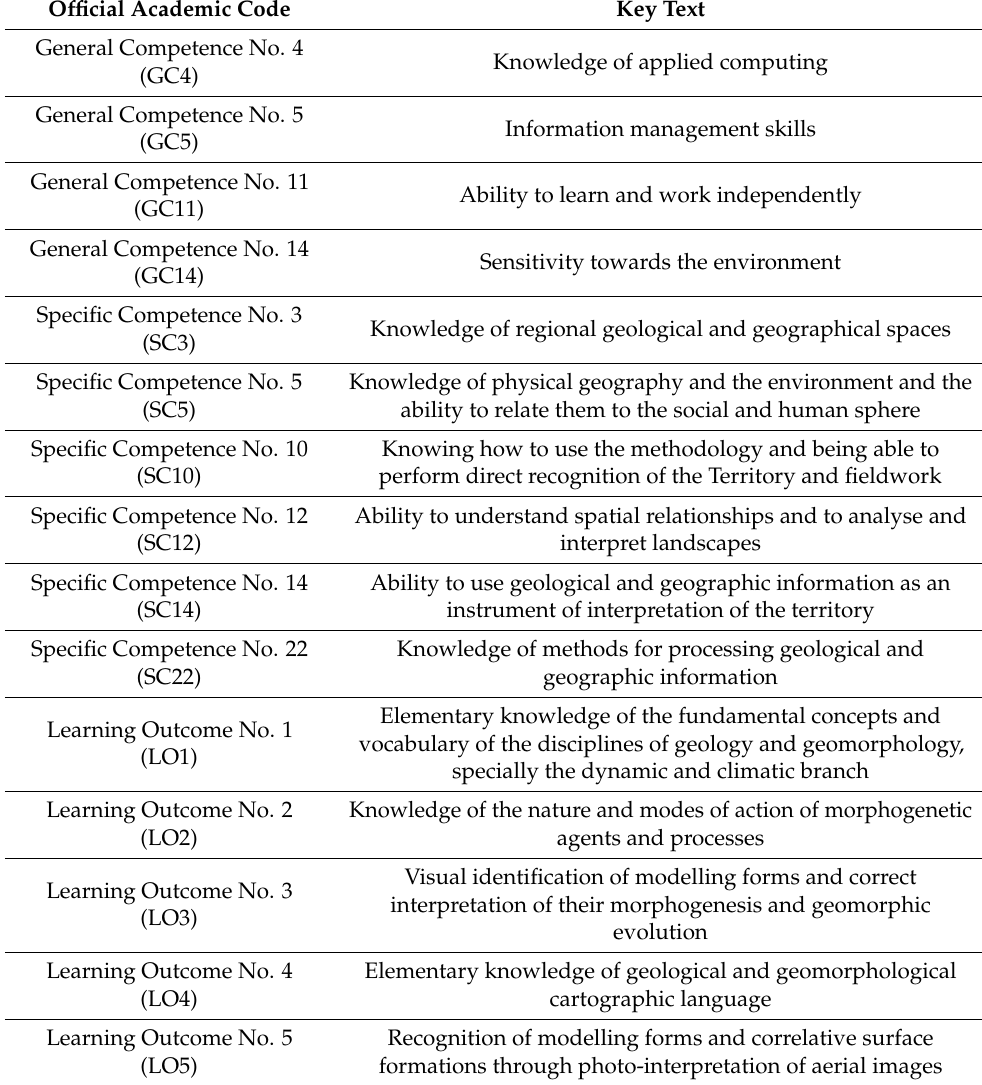
Table 1. Official competences and learning outcomes of the